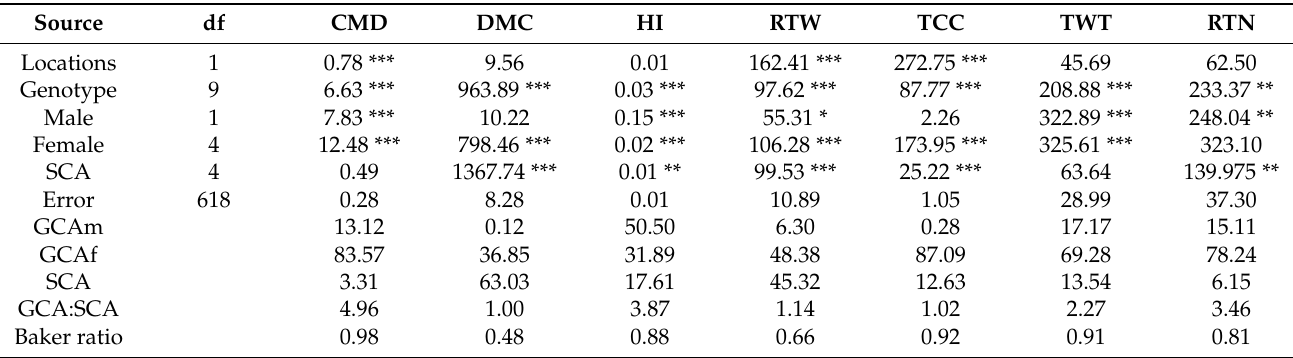
Table 3. Mean squares of crosses and sum of squares for combining ability effects of seven traits evaluated in 10 F 1 families and seven parents across two locations.